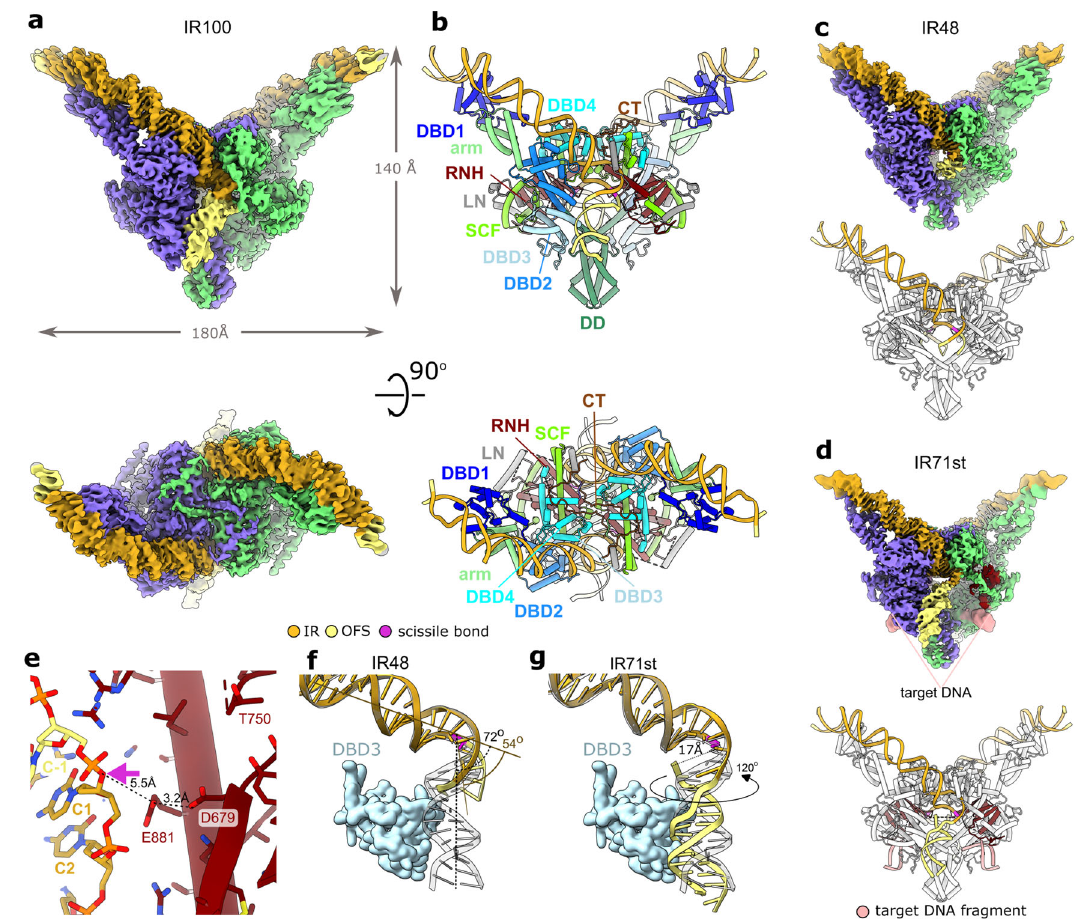
Fig.2|StructureofTnpA S911R withDNAsubstrates.a Cryo-EMmapofTnpA S911R in complex with IR100 substrate. The map is colored by protomers. The DNA is colored by functional regions as indicated in the visual legend. b Structure of TnpA S911R -IR100 complex shown in cartoon representation and colored by